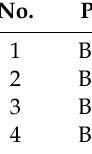
Figure 6. Load profile of JAMALI power grid: ( a ) general load profile during a representative weekday, ( b ) demand covered by fossil fuels, ( c ) demand covered by coal, and ( d ) demand covered by natural gas. Table 2. Period of the electricity market for frequency regulation.